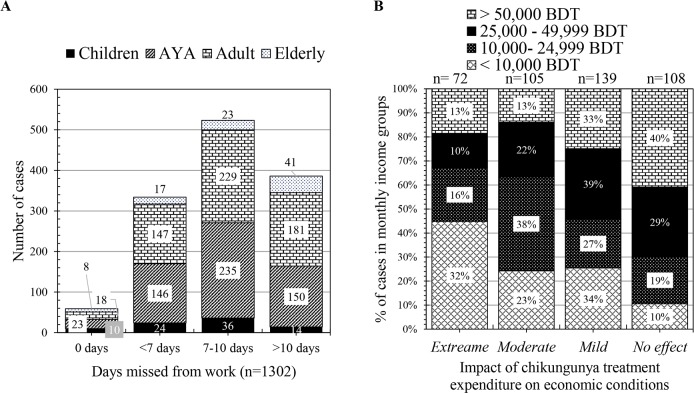
The economic impact of chikungunya infection on days misses from work (A) and rating versus income ranges as 100% staked column (B). Respondents were asked to rate the chikungunya healthcare expenditure on their economic conditions on a numeric rating scale of 1 to 10. Rating 8–10, 5–7, 2–4 and 1 is considered as extreme, moderate, mild and no impact on economic conditions of respondents, respectively. One column in B illustrates the relative percentage of cases from different income ranges. The exchange rate of 1 USD is about 82 BDT.